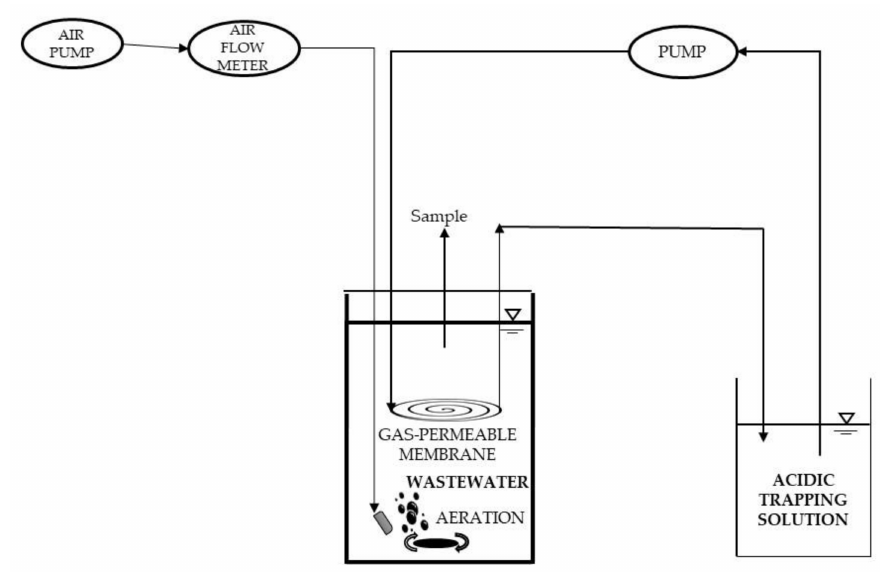
Figure 1. Schematic showing the experimental set-up.